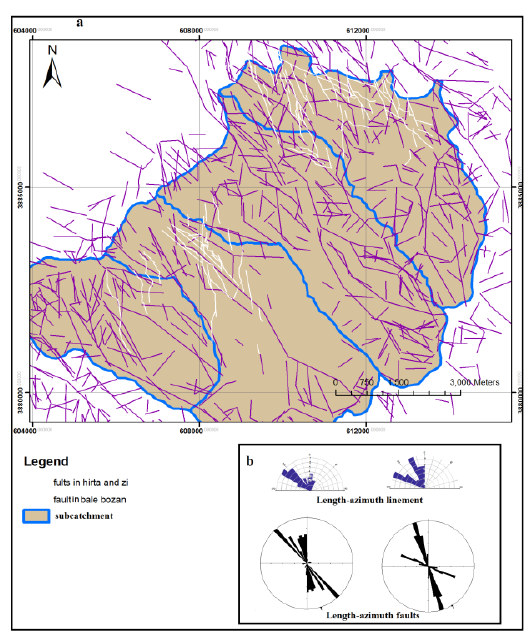
Fig 11. Earthly image (up) of Bale bozan Fault zones and identified through hill shade (down).